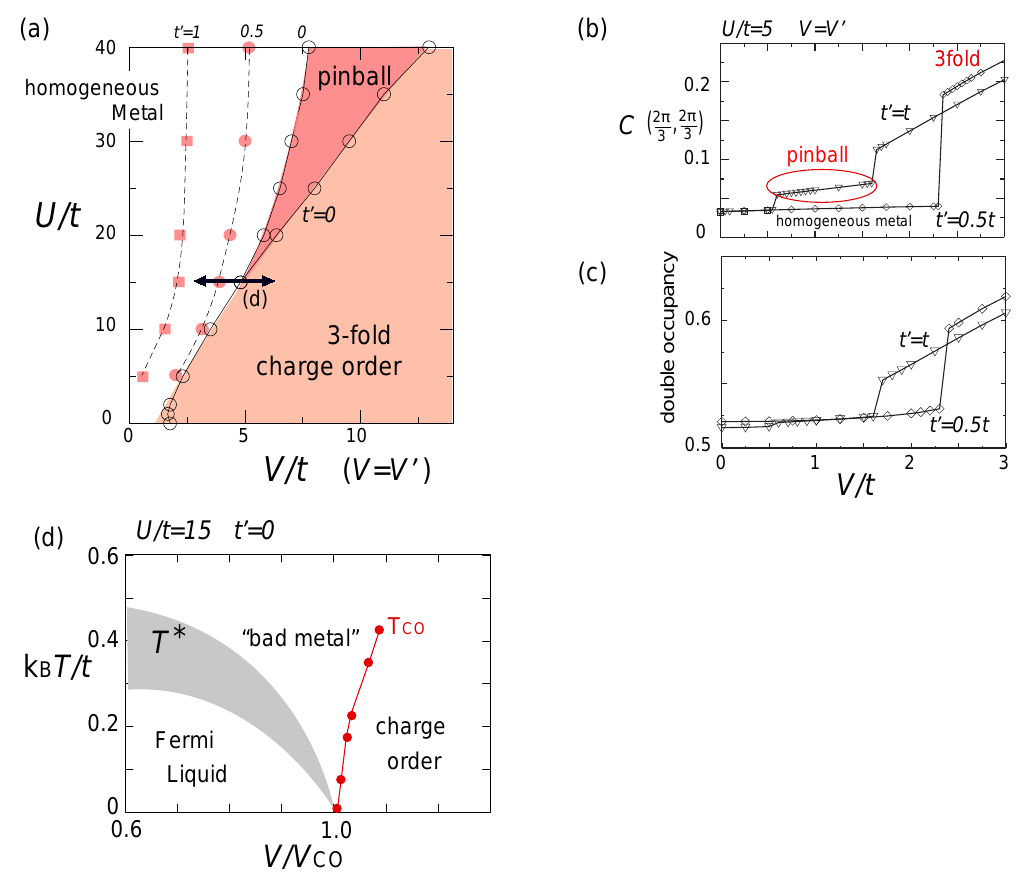
Figure 11. Numerical results of the 3/4-filled extended Hubbard model on the anisotropic triangular lattice, by Cano-Cortes et al . using exact diagonalization with N = 12 and 18. ( a ) U/t - V/t phase diagram; ( b ) Charge structural factor ( C ( k ) ) and ( c ) double occupancy against V = V (cid:48) at t (cid:48) = 0 . In the non-interacting limit, d = ( n/ 2) 2 = (0 . 75 / 2) 2 = 0 . 5625 , which increases to 0.66 in the three-fold state. C ( π/ 3 , π/ 3) ∼ n 2 / 3 and n 2 for the pinball and the three-fold charge order, respectively; ( d ) Finite temperature phase diagram along the bold arrows in ( a ) ( U/t = 15 , t (cid:48) = 0 ). Adapted with permission from [31,38], copyrighted by the American Physical